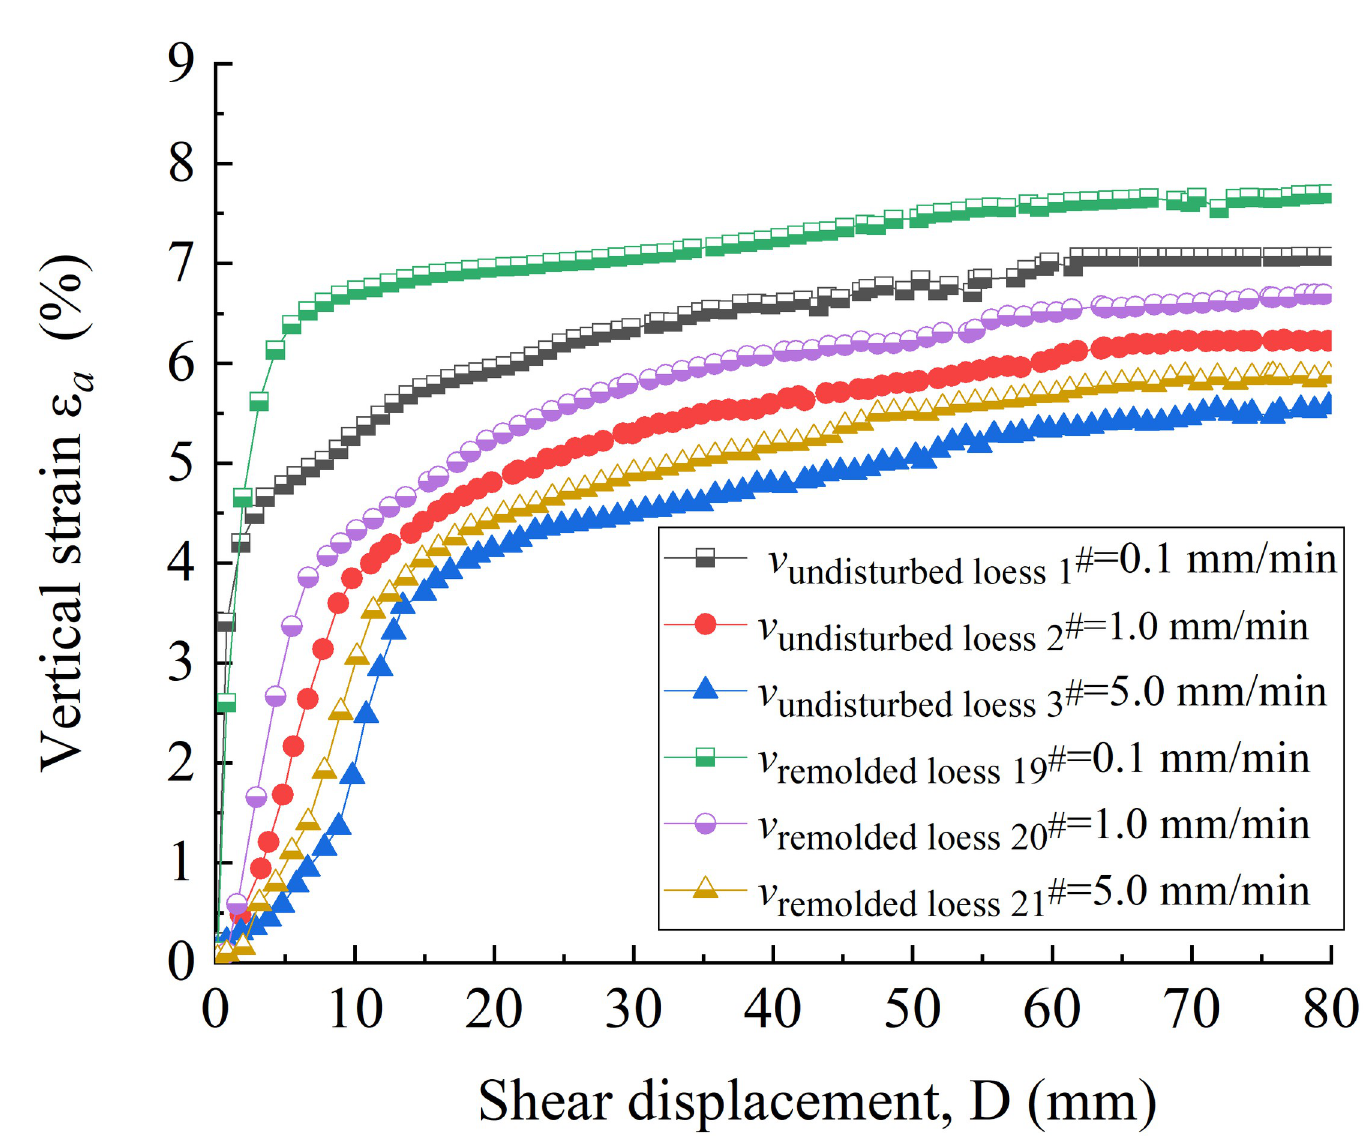
Fig 6. Vertical strain-shear displacement curve of 1 # - 3 # undisturbed and 19 # - 21 # remolded loess specimens under different shear rates.